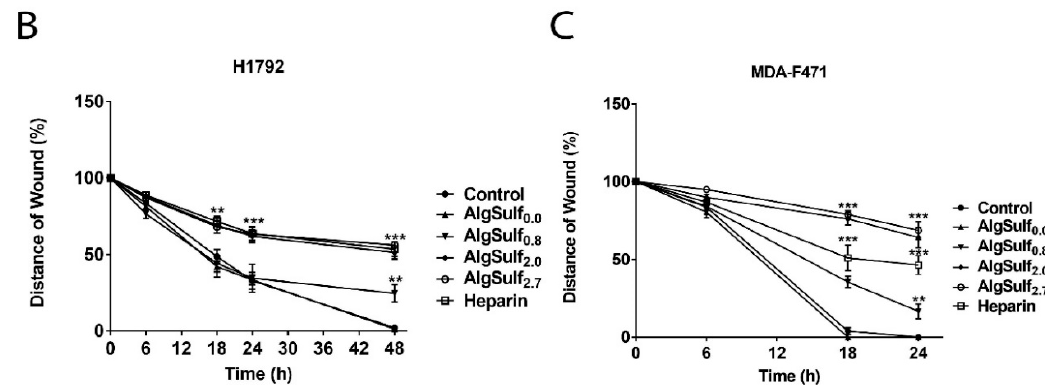
Figure 3. The effect of the DS of biomimetic sulfated GAGs on the migratory abilities of human (H1792) and murine (MDA-F471) LUAD cell lines. A scratch was made on a 12-well plate of confluent H1792 and MDA-F471 cells using a 200 µL micropipette tip and images were taken at T = 0, 6, 18, 24, and 48 h. ( A ) Representative bright-field images of H1792 and MDA-F471 wounds with different AlgSulf n . Results are expressed as the percentage of the wound distance in each group compared to its condition at T = 0 h for ( B ) H1792 and ( C ) MDA-F471 treated with AlgSulf n . Untreated cell layers were used as negative controls and heparin was used as a sulfated GAG positive control. Data represent the average of three independent experiments and are reported as mean ± SEM (** p < 0.01; *** p < 0.001) using two-way ANOVA followed by Bonferroni’s multiple comparison test. Scale = 100 µm.